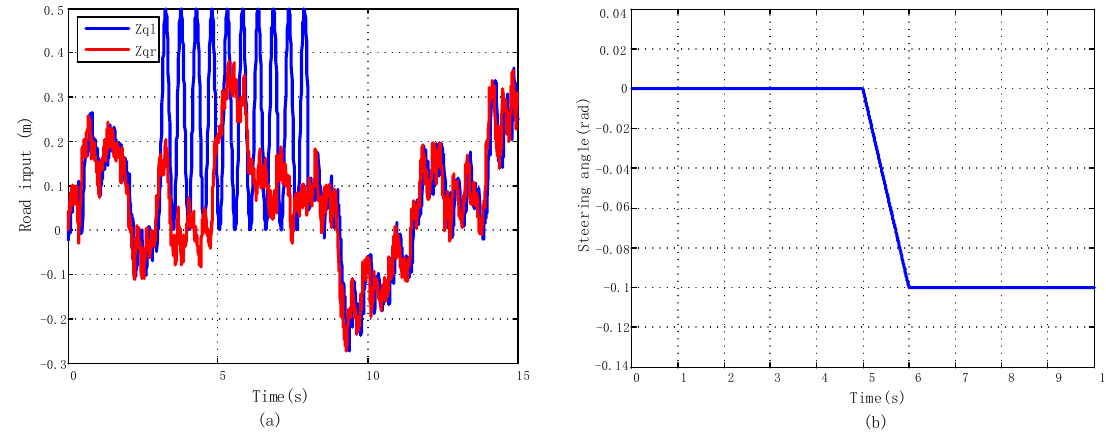
Figure 20. The input signals of vehicle: ( a ) the bump road; ( b ) the steering angle under J-turn maneuver.